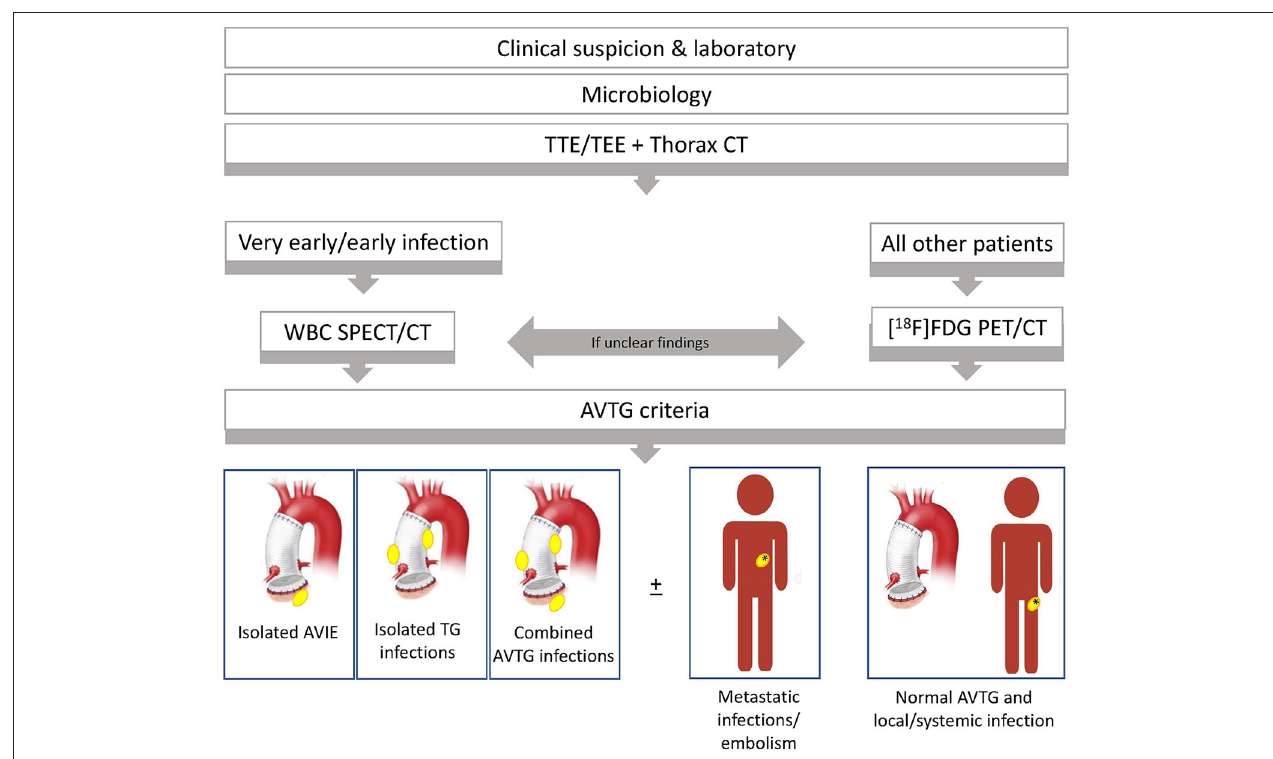
FIGURE 7 | Diagnostic flowchart, currently used in our institutions, developed the result of the study presented here. After a clinical and laboratory assessment for the pretest risk definition, echocardiography [either transthoracic echocardiography (TTE) and transesophageal echocardiography (TEE) followed by cardiac CT angiography (CTA), if needed] and CTA of the thorax are performed. According to our data, functional imaging is recommended whenever equivocal TEE/TTE and cardiac/thoracic CTA are present in high-risk patients to confirm the clinical suspicion of infection. Moreover, the use of functional imaging is supported to properly define the disease burden and prevent understaging, regardless of the positivity/negativity of TEE/TTE and/or CTA. This approach seems of value in complicated patients bearing high risk for surgical procedures. The decision of whether to perform [ 18 F]FDG PET/CT and radiolabeled WBC is generally taken based on the clinical background, on clinical condition/compliance of patient, and the pretest probability of infection. As a general rule, radiolabeled WBC is preferred in case of very early and early infections. [ 18 F]FDG PET/CT is generally performed in all the other cases. However, when [ 18 F]FDG PET/CT findings are inconclusive or in high-risk patients, we need confirmation of the extent of disease before surgery and we follow a tandem approach consisting of [ 18 F]FDG PET/CT plus WBC